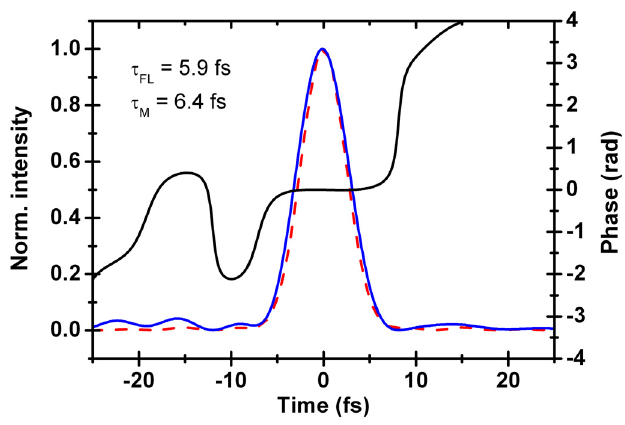
Figure 9. Phase transfer in a circular nondiffracting light bullet (pulsed needle beam, length of the nondiffracting zone about 1 m), measured with an FC-SPIDER (APE); black curve: temporal phase, dashed red curve: pulse calculated for the Fourier transform limited case, blue curve: pulse retrieved from measuring data. τ pulse durations, respectively. The distance of the entrance window of the SPIDER from the SLM was about 20 cm (the effective distance was higher because of the additional internal path in the SPIDER system). The diameter of the light bullet at the entrance of the SPIDER was 1